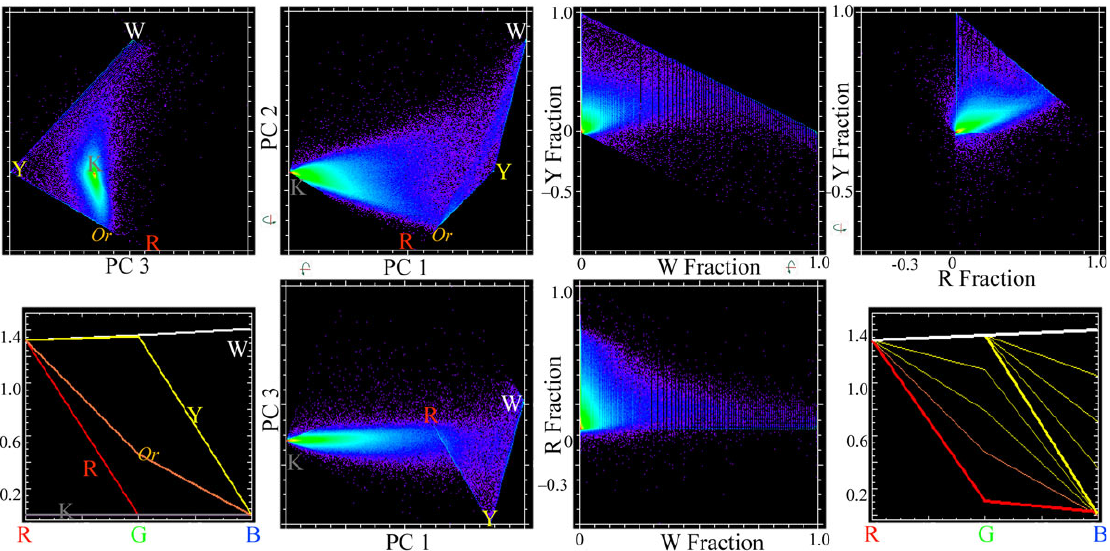
Figure 6. Three-dimensional spectral feature space and spectral fraction space for the 18-city com- posite (5500 K). Density-shaded orthogonal projections of the principal component distributions (left) show luminance corresponding to PC 1 with white, yellow and red endmembers bounding a triangular plane of maximum luminance perpendicular to the gray axis extending to the dark (K) endmember. Since very few pixels are pure red, the distribution trends toward orange mixtures near the red endmember. Projections of the WYRK fraction space (right) are largely bounded by linear mixtures with a small number of blue pixels with slightly negative yellow or red fractions. The WYRK endmembers represent an optimized, more nearly orthogonal basis for the urban lightscape, as imaged by multispectral RGB sensors.